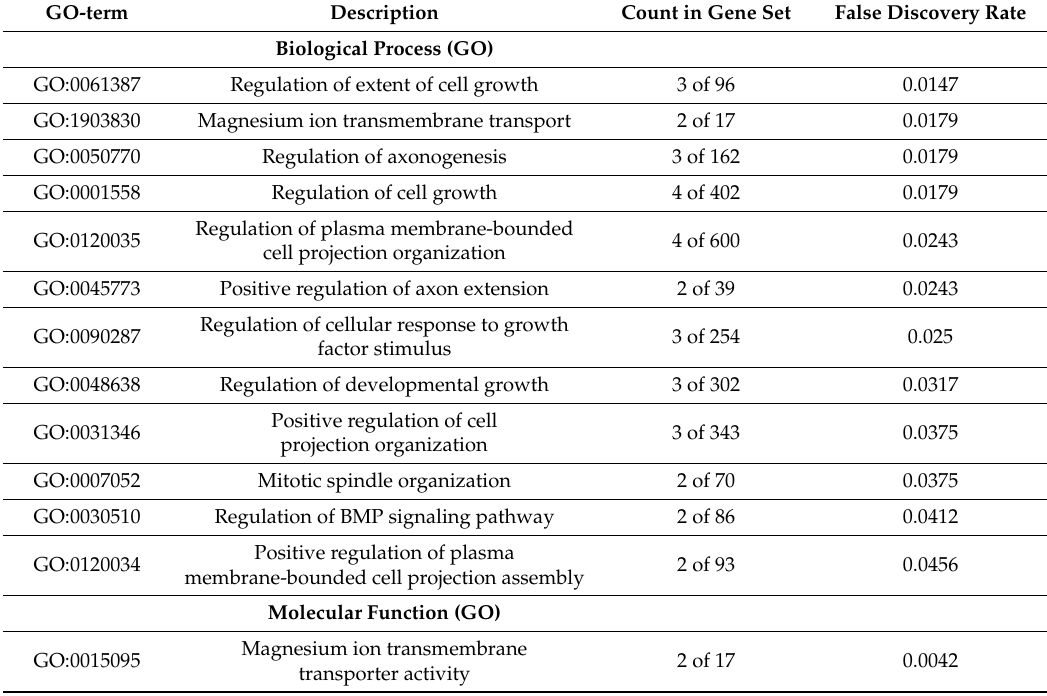
Table 2. Predicted STRING Protein–Protein Functional Interactions for NIPA1, NIPA2, CYFIP1, and TUBGCP5